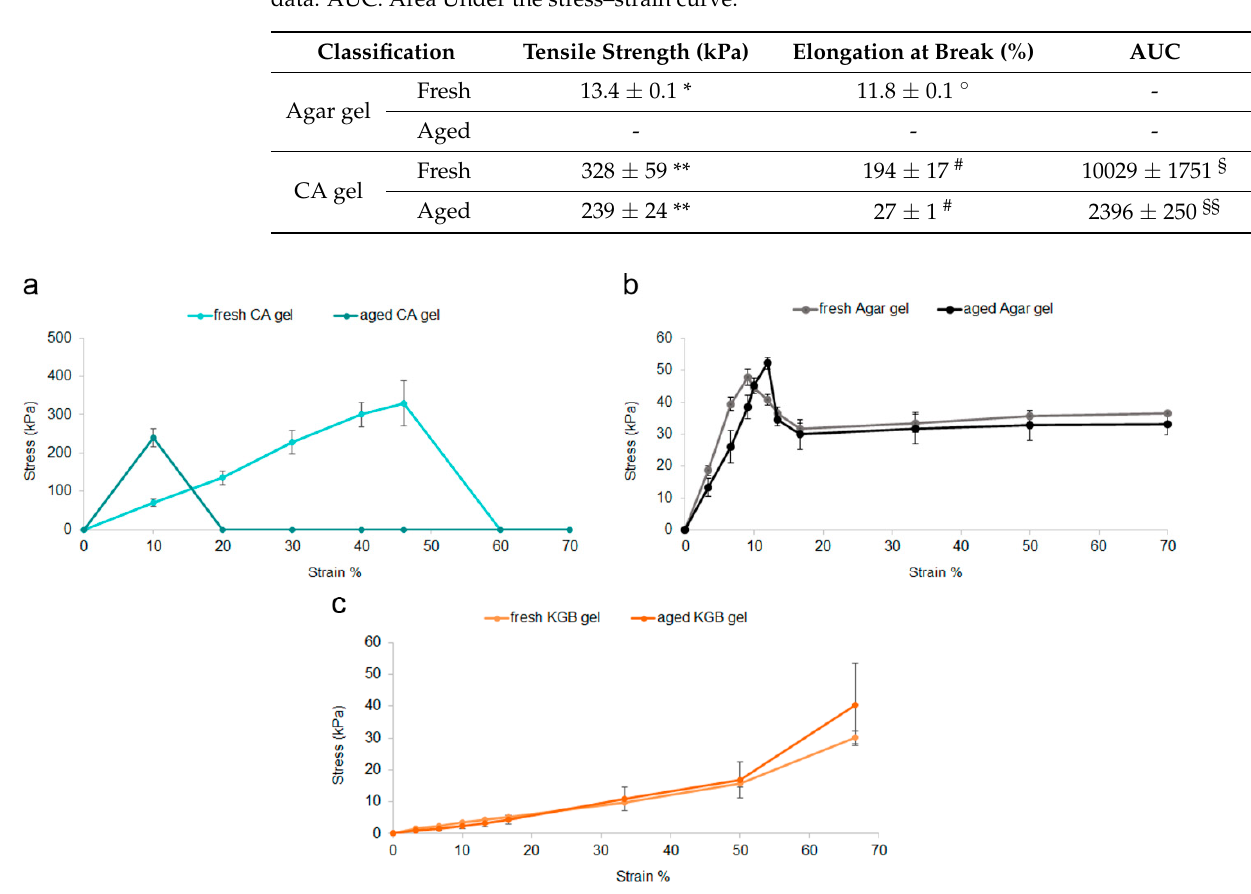
Figure 2. Stress–strain curves of fresh and aged Agar gel ( a ), CA gel ( b ), and KGB gel ( c ).